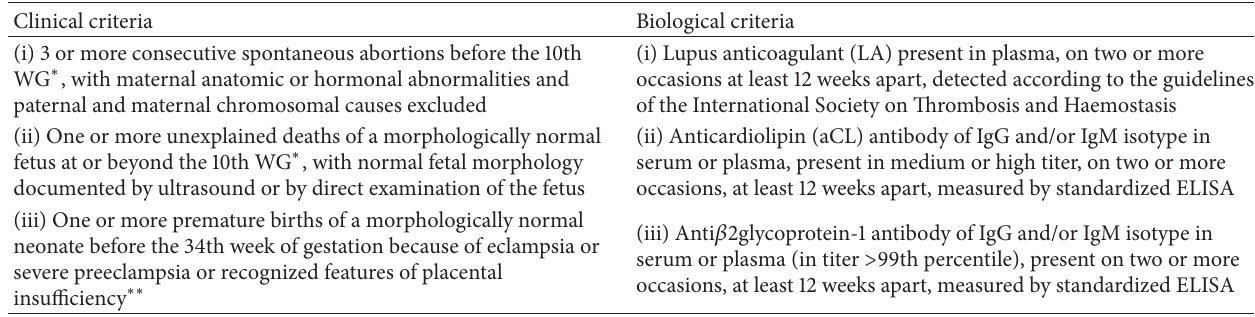
Table 1: Criteria of obstetrical APS [3]. APS is diagnosed when at least one of the following clinical criteria and one of the following laboratory criteria are